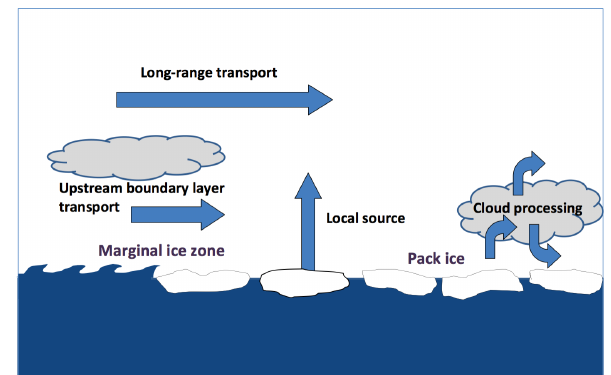
Figure 1. Schematic view of the sources and transport mechanisms of aerosol particles over the summer Arctic pack ice, adapted from Kupiszewski et al.